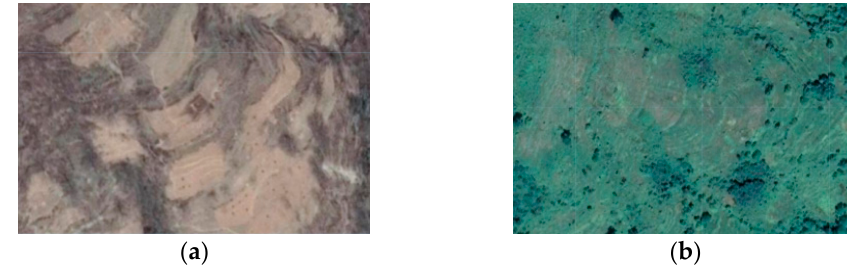
Figure 13. The distribution of land use transformation from 1990 to 2017 in the Qinling Mountains.